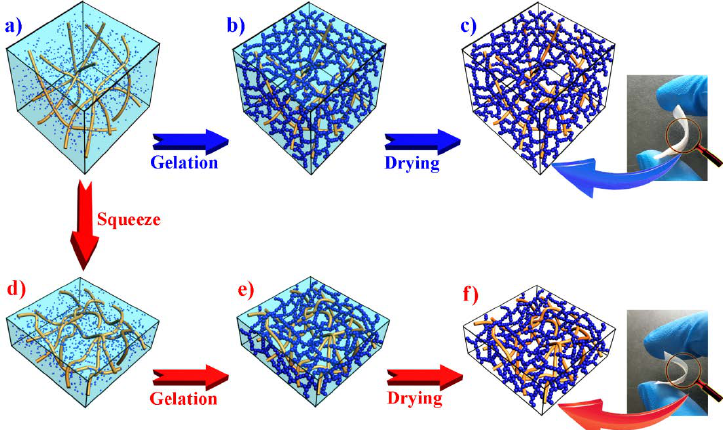
Figure 4. The sol-gel process of silica alcosols in BC matrix before (top) and after (bottom) squeezing some of the silica sols from the matrix respectively. ( a ) and ( d ): BC matrix with silica alcosols; ( b ) and ( e ): BC-silica composite gels; ( c ) and ( f ): composite aerogels. Photographs show the CA-4 (top) and CA-4/3 (bottom) samples.